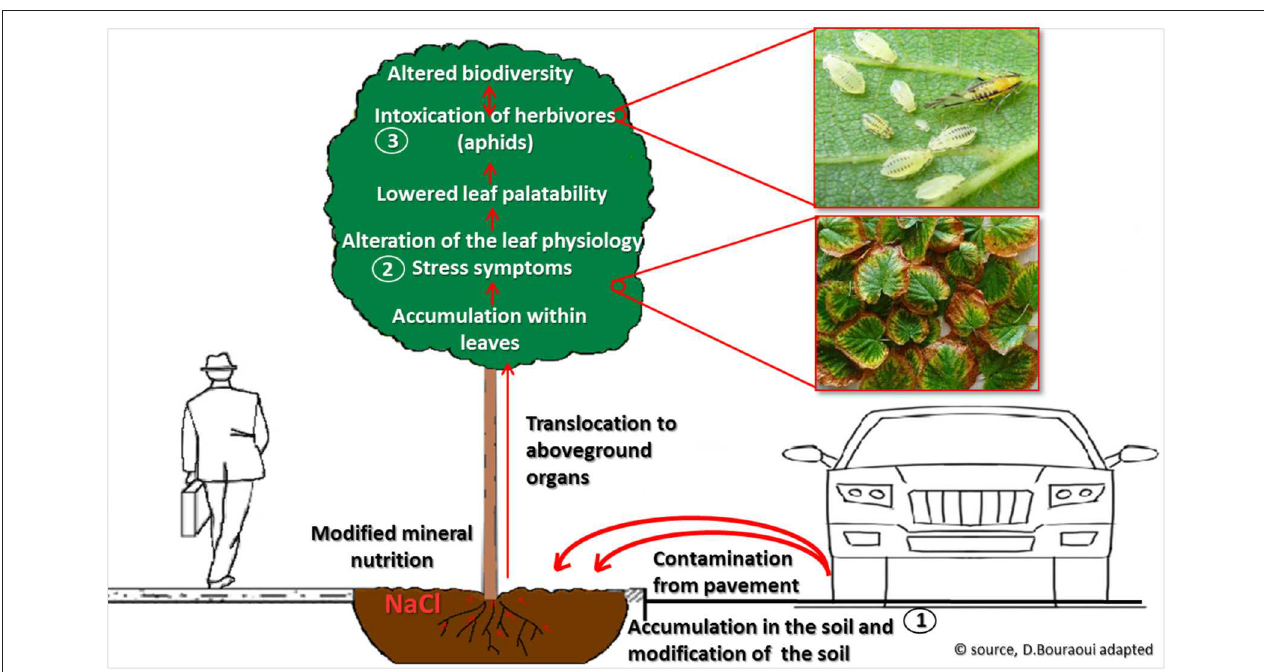
FIGURE 6 | Cascading effects de-icing salts on street greenery and biodiversity, from soil infiltration and contamination (1), to foliage injury (2), and to altered diversity of arthropods communities in the canopy